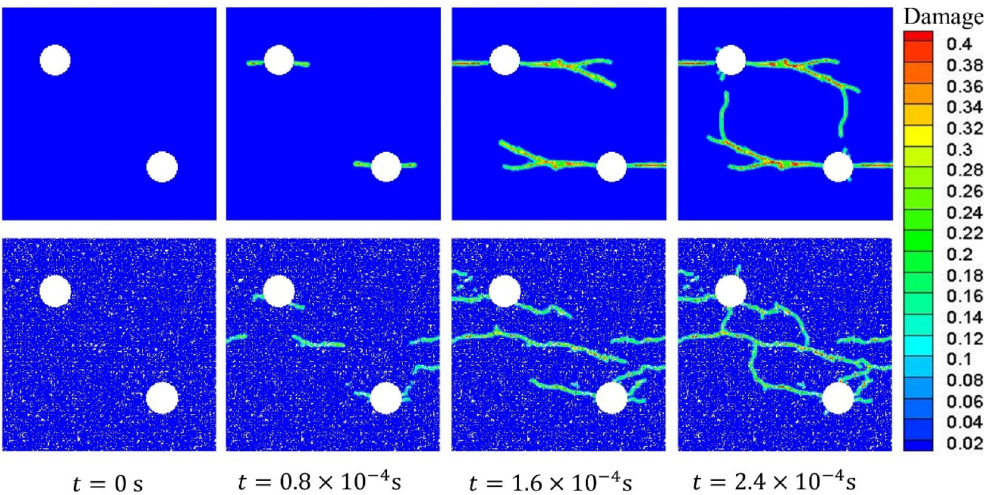
Figure 12. Paths of the multiple-crack propagation of the plate specimen under tensile loading at different